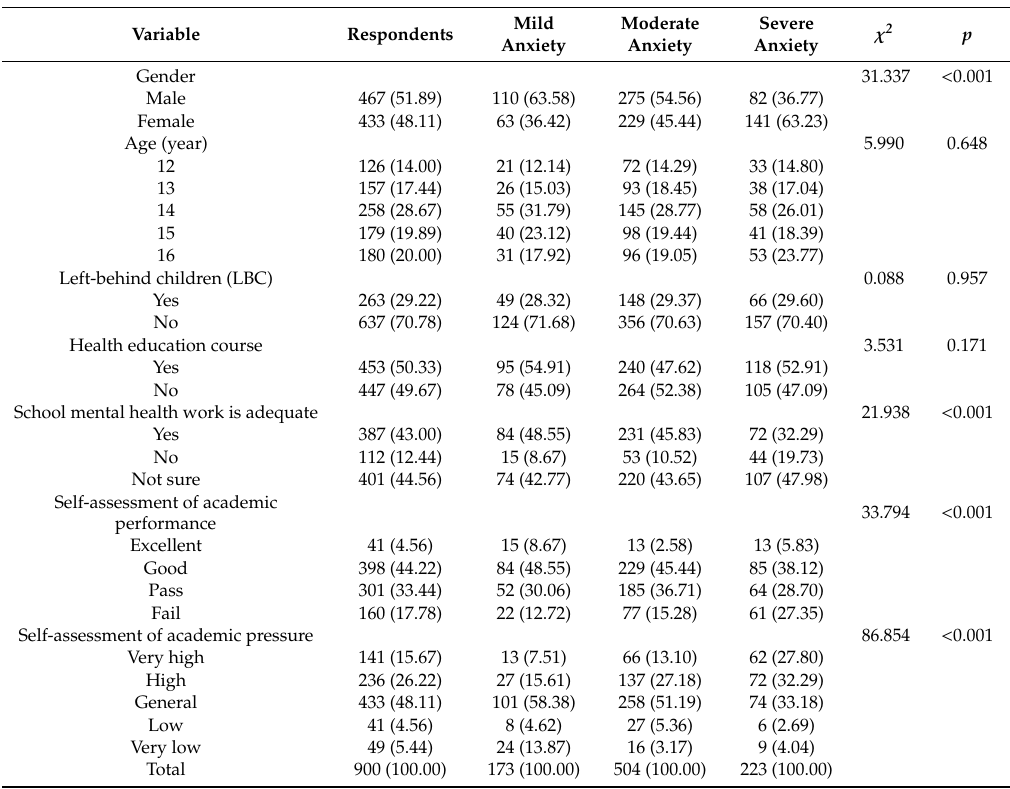
Table 2. Demographic characteristics and anxiety category of junior high school students in the rural areas of Jiangxi